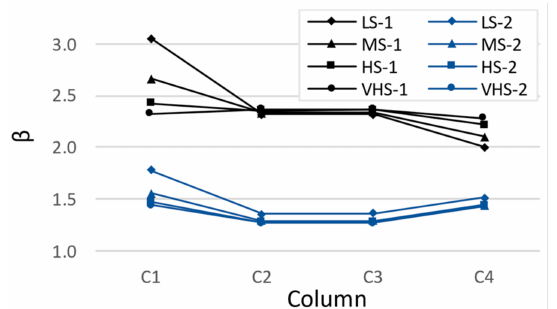
Figure 16. Buckling length factors determined from the 1st sway buckling mode for the 1st floor columns and the 2nd sway buckling mode for the 2nd floor